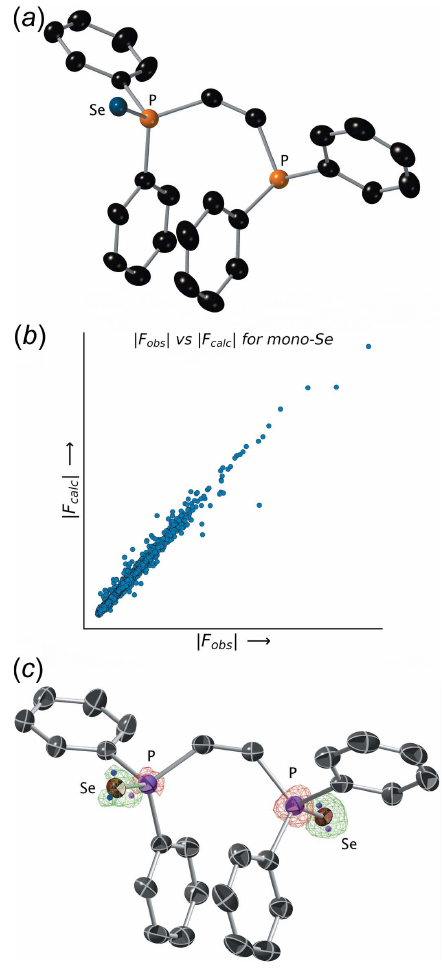
Figure 2 ( a ) An ellipsoid (50% probability) plot for the major component of the mono-selenide model. ( b ) A plot of | F obs | vs | F calc | values for the mono- selenide model. Note the extent of scatter in the plot. ( c ) A difference- electron density map reveals positive (green) electron density at the chalcogen site and negative (red) contours at the phosphorus sites. Small peaks within the positive density are represented by coloured dots. The single Se atom in trial 1 is split with occupancies of 0.526 (2) and 0.474 (2) over the two chalcogen sites.